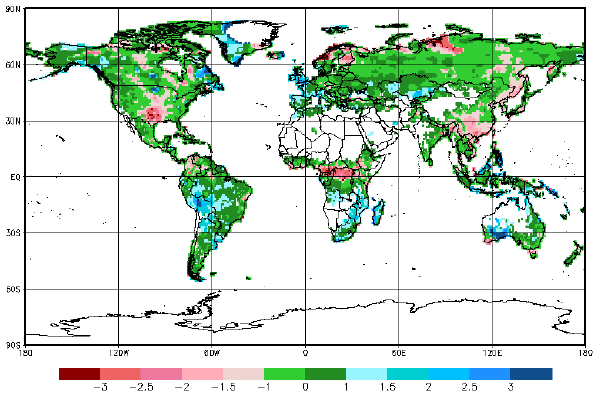
Figure 3. The SPI-DWD for January 2014 with 1-month accumu- lation interval. Green means normal precipitation, blue wetter than normal and red drier than normal (drought). Grid cells without data are white.